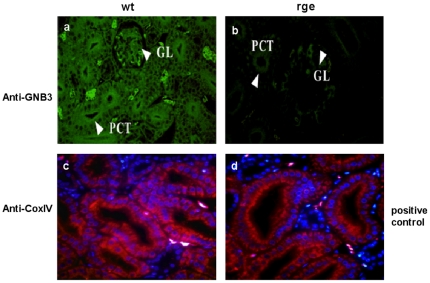
Predominant GNB3 expression in wt kidney sections.Immunohistochemistry of GNB3 (green) on kidney sections shows high expression in the epithelial border of the tubules, proximal convoluted tubule (PCT) and glomeruli (GL) of normal kidneys (Fig. 8a), which are less evident in rge sections (Fig. 8b). Postive control staining of COX IV antigen (red) is observed in both rge and wt sections (Fig. 8c & 8d). Figures are representative of different images taken from different fields of view in three individual experiments (n = 3). Magnification 60×.